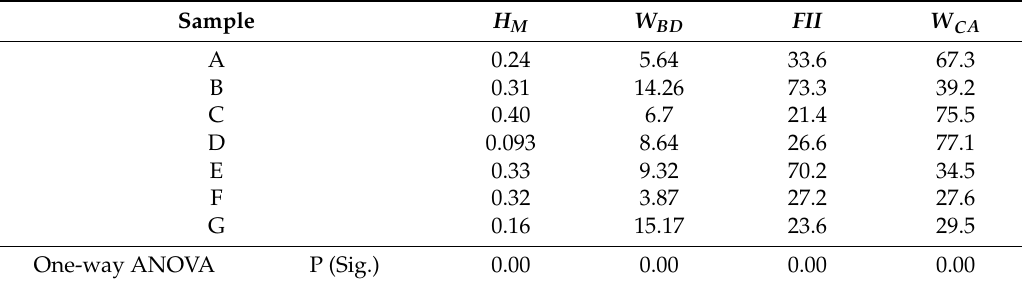
Table 5. MTT test results of tactile properties by mean values.